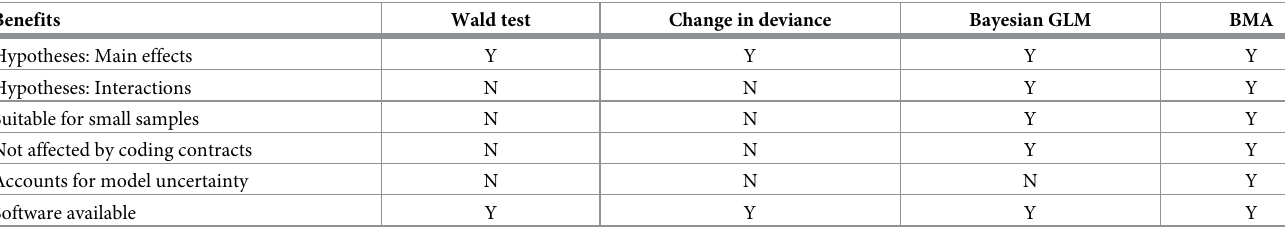
Table 15. Comparison of statistical techniques and their main